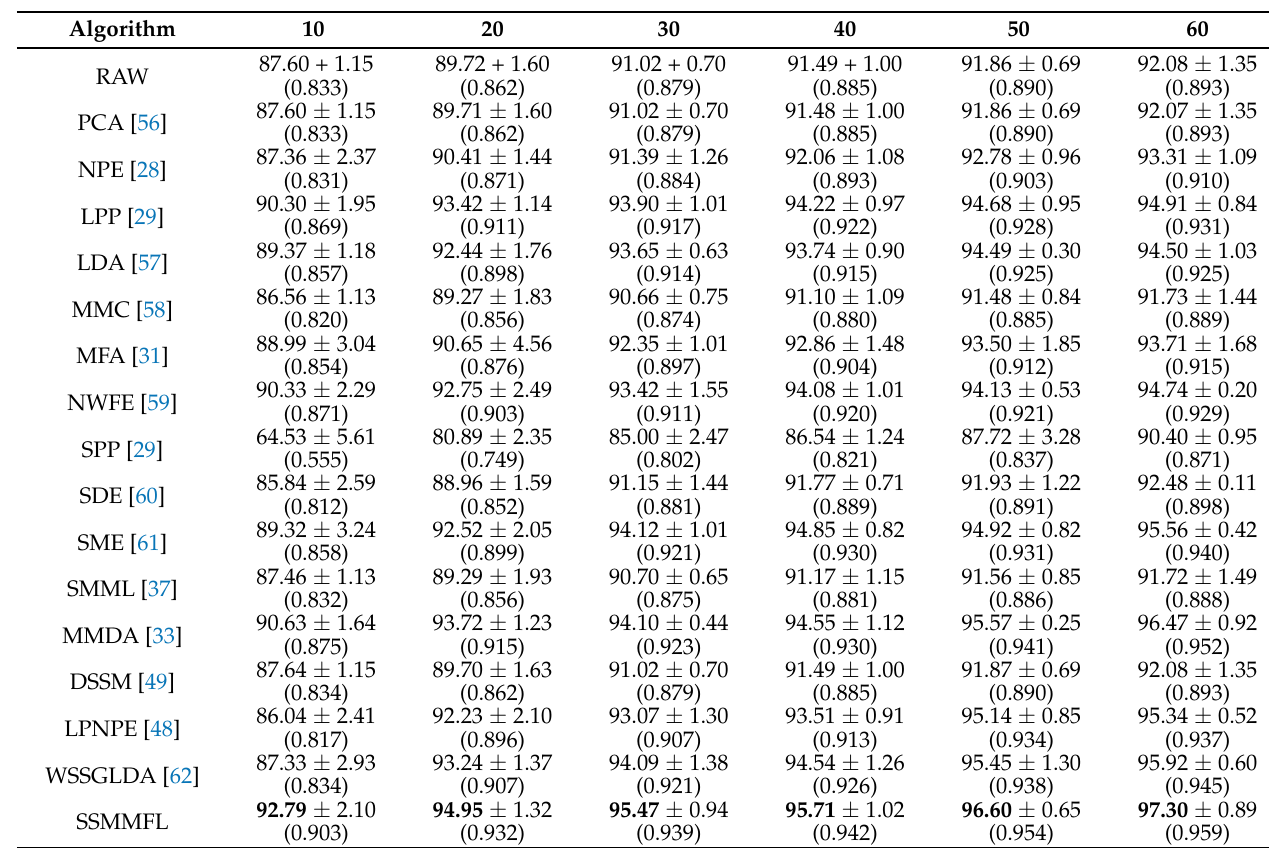
Table 2. Classification results with different values of n i on the Heihe dataset with NN classifier. Each method has two rows, where the first row is the OA ± STD (%) and the second row is the